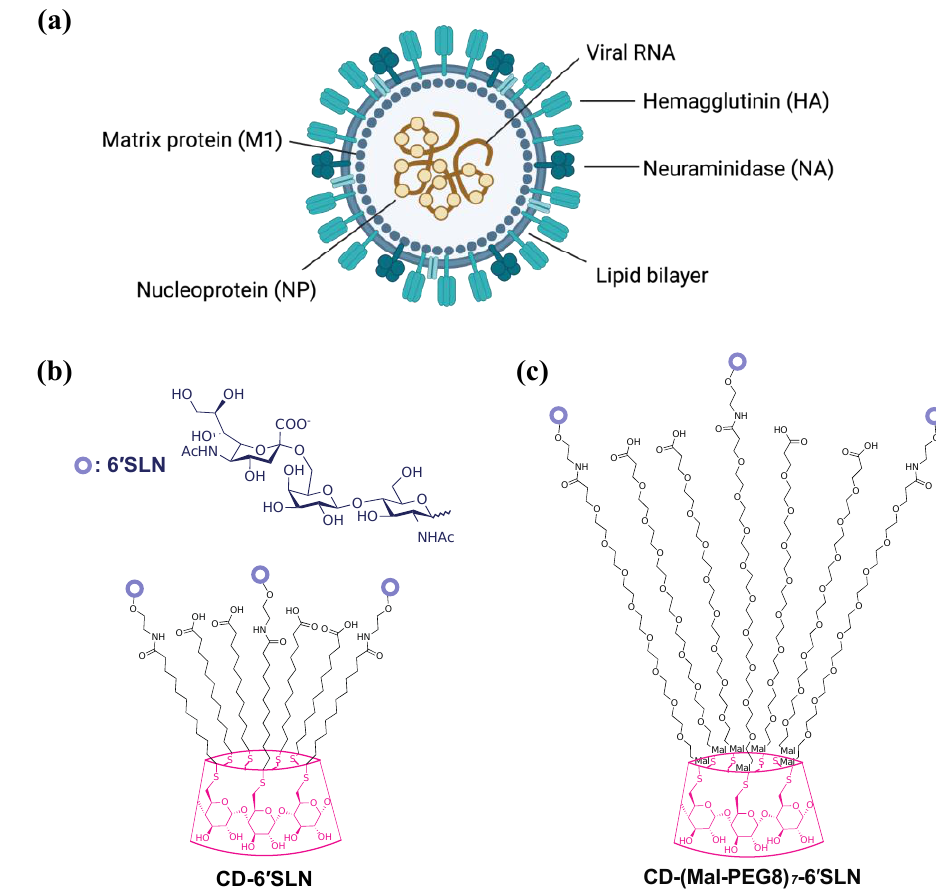
Figure 1. ( a ) Schematic drawing of the influenza virus. ( b ) Chemical structure of virucidal CD-6 (cid:48) SLN; schematic drawing of the influenza virus. ( c ) Chemical structure of CD-(Mal-PEG8) 7 -6 (cid:48) SLN. In general, influenza antiviral drugs target various stages of the viral replication cycle. Small-molecule viral enzyme inhibitors [2], such as the M2 proton channel blocker amanta- dine, endonuclease inhibitor baloxavir marboxil, and neuraminidase inhibitor oseltamivir, target the intracellular viral replication processes of viral fusion, genome replication, and viral budding, respectively. Large molecules, such as therapeutical antibodies [6], interact directly with extracellular virions, in particular viral membrane proteins, to prevent viral attachment or fusion to host cells. Notably, such an extracellular mechanism avoids many side effects, often associated with the impact on the intracellular physiology of host cells. Influenza HA has been studied as a target of antiviral drugs for decades, though no drug candidate with an HA inhibition mechanism has been licensed for clinical use. HA binds to sialic acids of glycoproteins and glycolipids on the cell surface to allow viral entry into the host cell. Therefore, sialic acid-based glycomimetics could be a potential